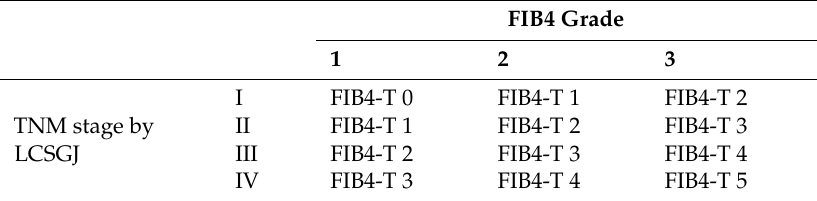
Table 1. Definition of the Fibrosis-4 (FIB4)-T scoring